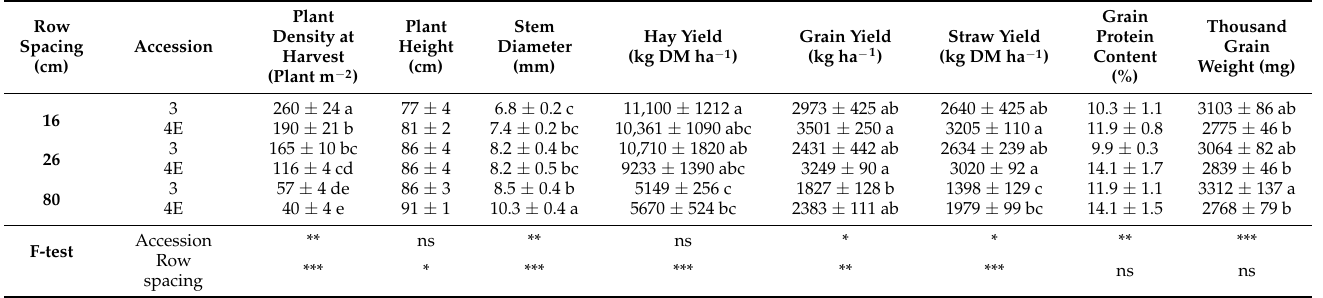
Table 3. Row spacing, plant density at harvest, yields, growth, and grain-quality parameters of quinoa accessions 3 and 4E sown in November 2019. Results are presented as mean value ± standard